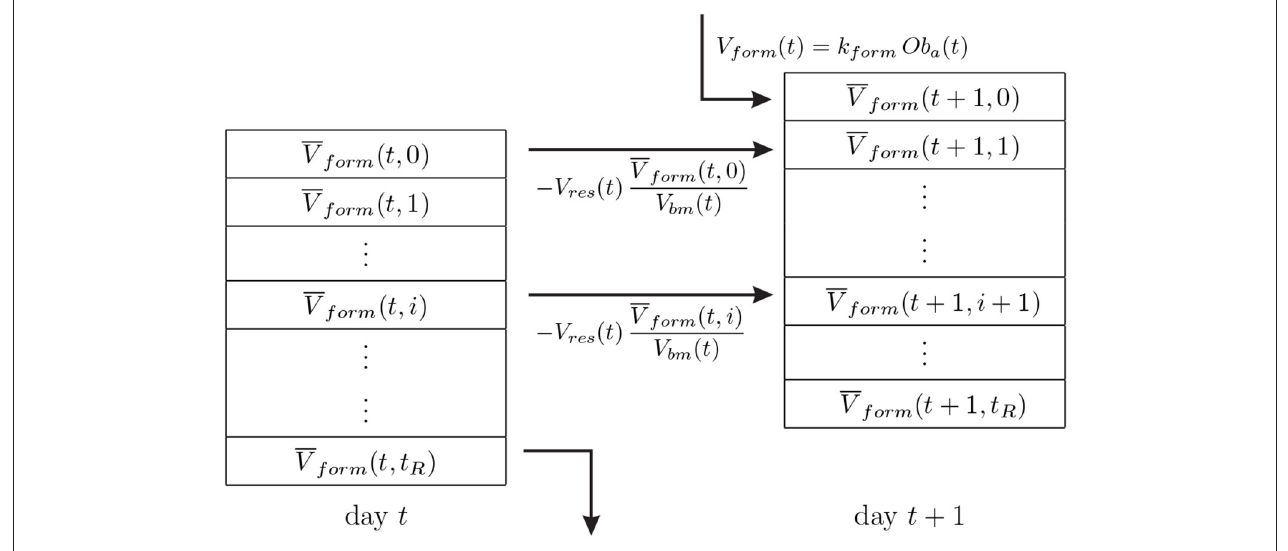
FIGURE 9 | FIFO (first in - first out) queue algorithm used to update the distribution of tissue patches of different ages within the RVE.